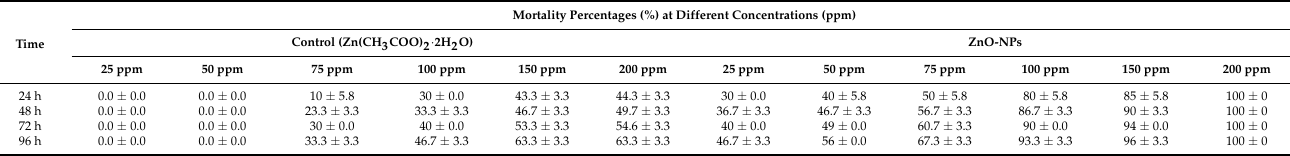
Table 1. The efficacy of different concentrations (200, 150, 100, 75, 50, and 25 ppm) of bacterially synthesized ZnO-NPs as a larvicidal agent against third instar larvae of Culex pipiens